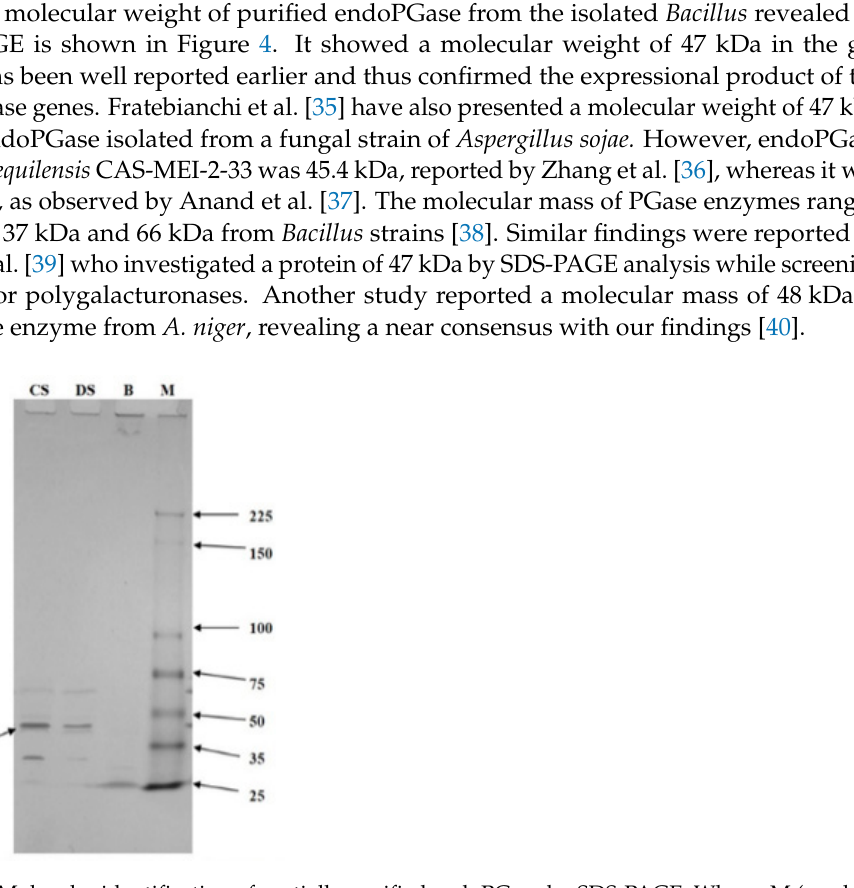
Figure 4. Molecular identification of partially purified endoPGase by SDS-PAGE. Where: M (marker), B (blank) DS (diluted enzyme sample) and CS (concentrated enzyme sample), respec- B (blank) DS (diluted enzyme sample) and CS (concentrated enzyme sample), tively.